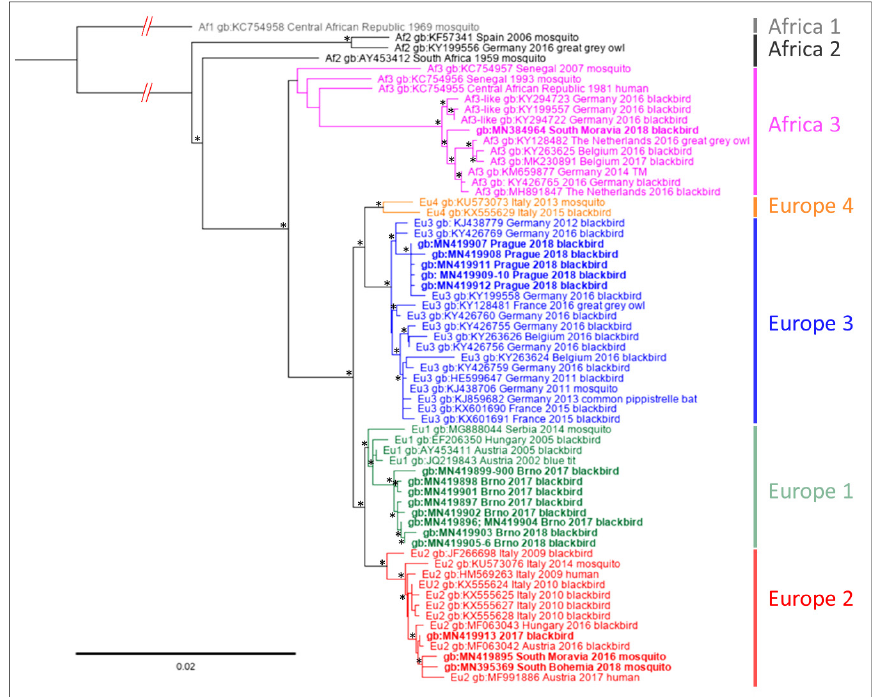
Figure 2. Phylogenetic maximum likelihood tree based on partial NS4B-coding nucleotide sequence and complete-coding sequences of NS5 protein of Usutu virus (nucleotide positions 7372–10,398